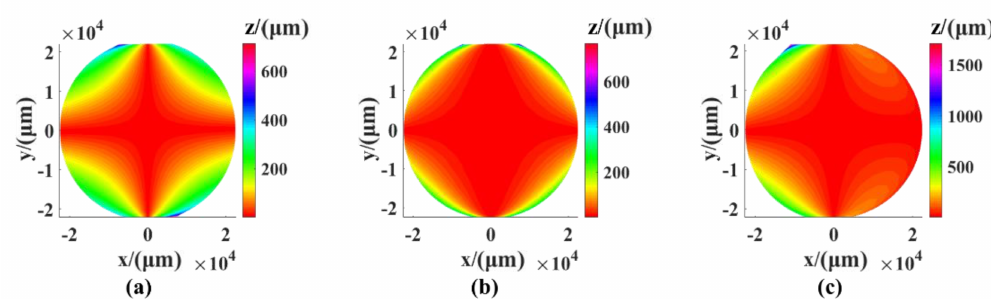
Figure 6. The shape error caused by the direction deviation in different directions: ( a ) The X direction, ( b ) the Z direction, and ( c ) the XZ direction.